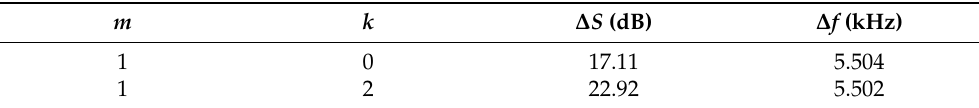
Figure 3. Plot of the simulated PSD function using a 100 m long fiber delay line. Table 1. Summary of results obtained through the analysis of the theoretical PSD plotted in Figure 3, using two different sets of